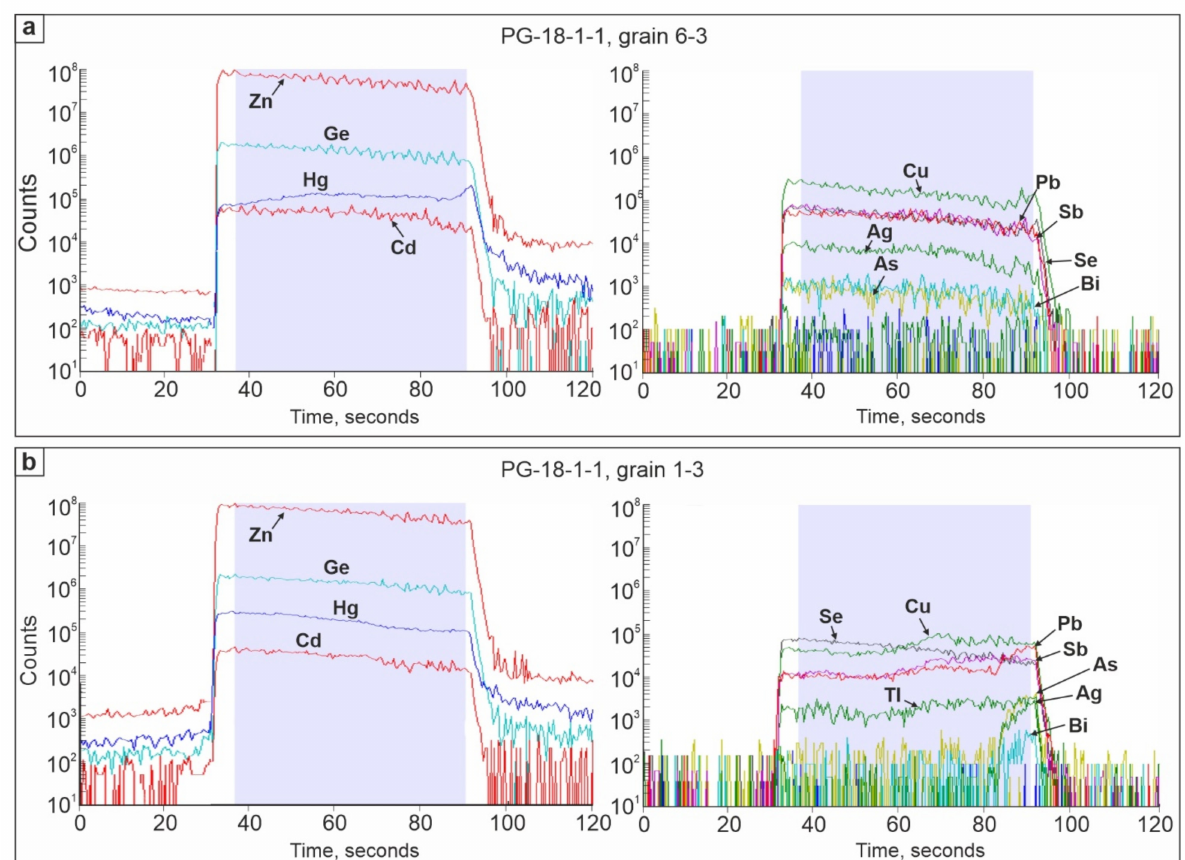
Figure 16. Representative single-spot LA-ICPMS spectra (blue shading) for selected elements in heterogeneous medium-Hg sphalerites without mineral inclusions ( a ) and with Pb-Sb-(Cu-Ag-Bi) sulfosalt and/or galena inclusions ( b ). For details of Hg distribution see Figures 11 and 13. For sphalerite compositions see Tables 4 and